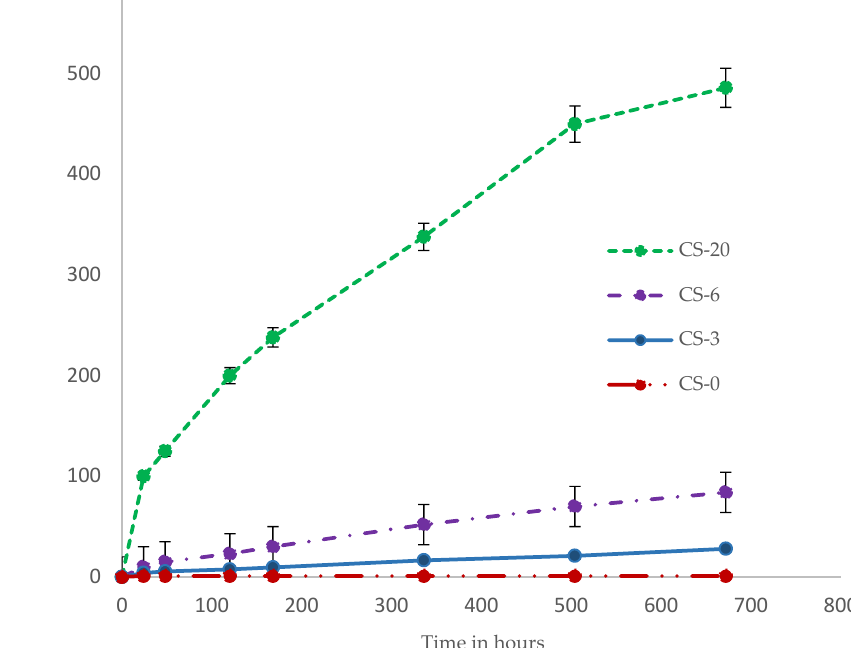
Figure 3. Cumulative release profile data of calcium ions from the composite specimens show escalating release of calcium ions with increasing percentages of MCP.